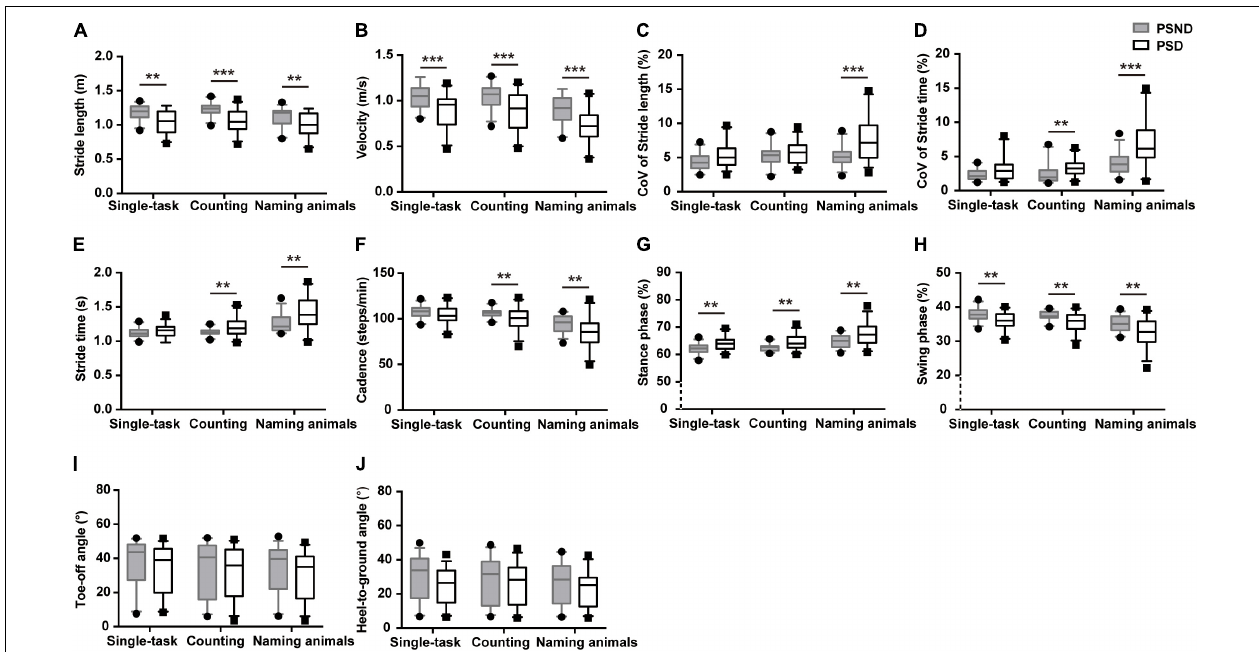
FIGURE 2 | The comparisons of spatiotemporal gait characteristics between individuals with post-stroke non-dementia (PSND) and individuals with post-stroke dementia (PSD) in three gait paradigms. (A,B) The pace domain of stride length and velocity. (C,D) The variability domain of coefficient of variation (CoV) of stride length (CoV SL ) and stride time (CoV ST ). (E–H) The rhythm domain of stride time, cadence, and percentages of the stance and swing phases. (I,J) The ToA and HtA of PSD and PSND individuals. ** p ≤ 0.01, *** p ≤